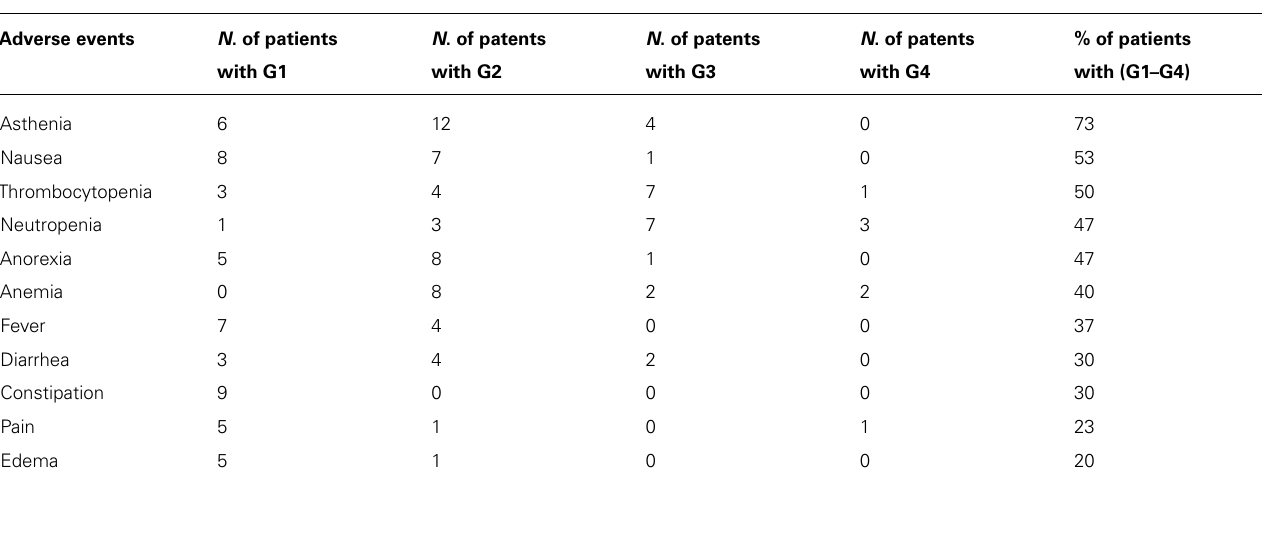
Table 5 |Adverse events in ≥ 20% of